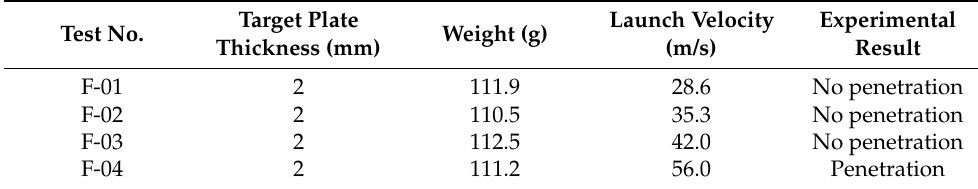
Table 2. Experimental